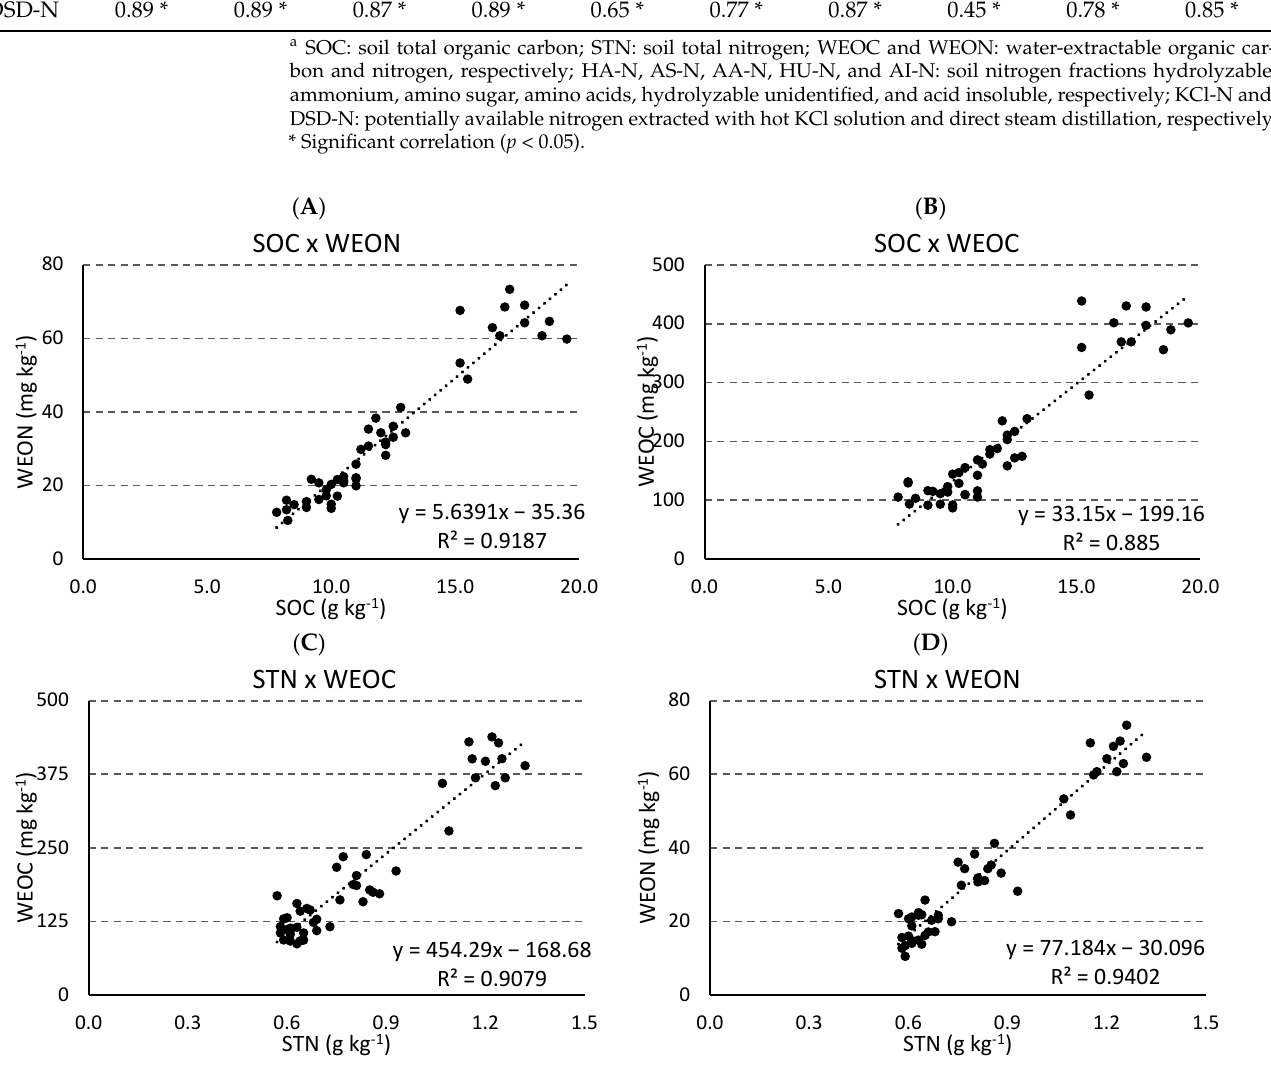
Table 8. Correlation coefficients among soil carbon and nitrogen forms, nitrogen fractions, and potentially available nitrogen observed in a long-term no-till experiment with different cover crops and nitrogen fertilizer doses. Canavalia ensiformis ; lablab bean: Dolichos lablab ; velvet bean: Mucuna cinerea ; millet: Pennisetum americanum ) grown before maize, under no-till system. N0 and N1: 0 and 120 kg N ha − 1 , respectively, applied in maize crop as topdressing fertilization. b DSD-N and KCl-N: soil potentially available N extracted by direct steam distillation and hot KCl solution, respectively. c Means followed by different letters, uppercase in the lines and lowercase in the column, differ from each other according to Tukey’s test ( p < 0.05).